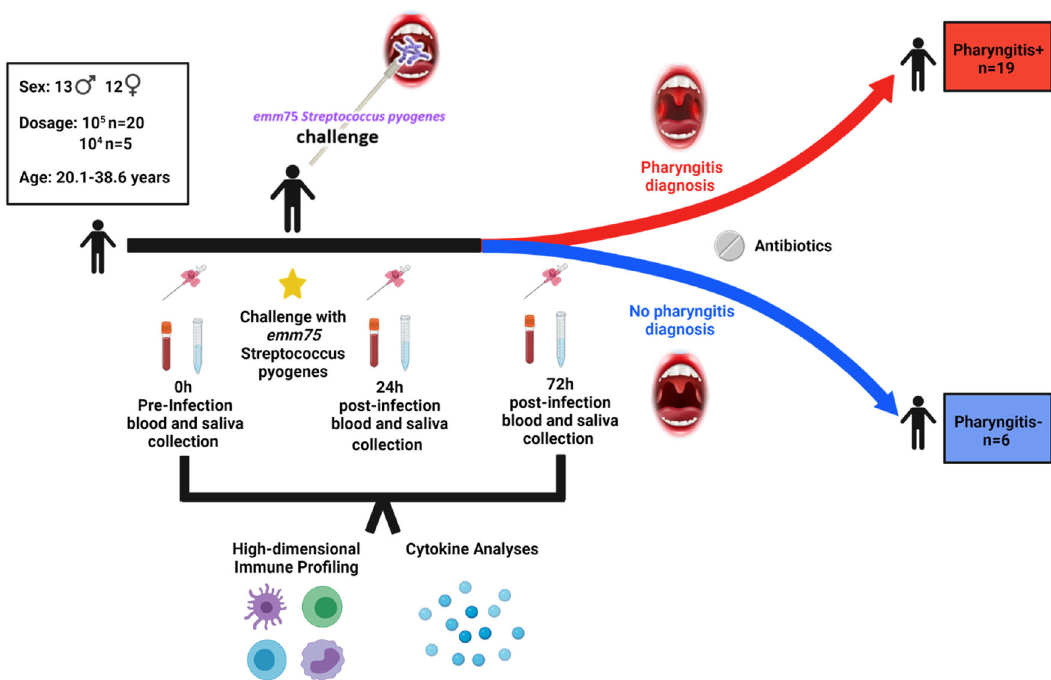
Fig. 1 Human challenge with Streptococcus pyogenes . Schematic of Streptococcus pyogenes human-challenge model. Details participant demographics, timepoints, outcomes and analyses performed. Figure created with